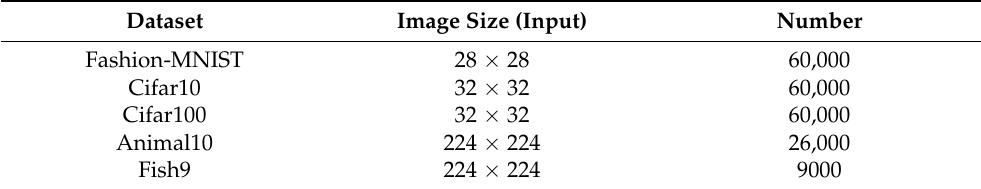
Table 1. Image dataset